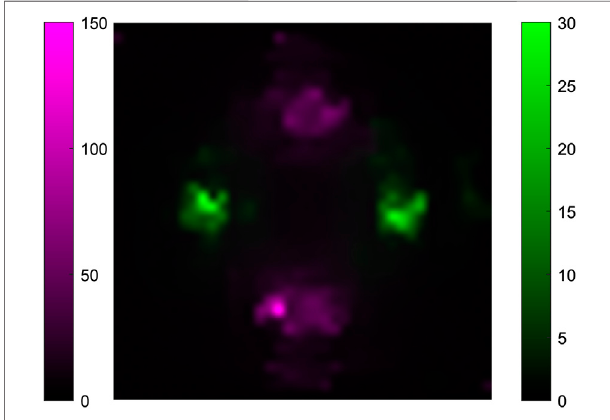
FIGURE 12 | Fusion of X-ray fl uorescence computed tomography images of I and